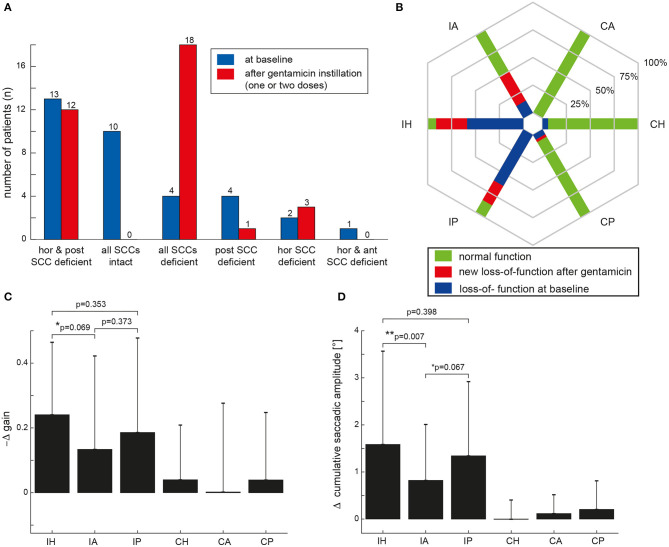
(A) Distribution of ipsilesional impairment in semicircular canal (SCC) function based on the two reviewers' ratings both at baseline (in blue) and after intratympanic gentamicin treatment (one or two treatments, individually different) (in red). In (B), the percentage of patients with normal function before and after gentamicin instillation (green areas) and with hypofunction based on the reviewers' overall ratings for the different SCCs [horizontal (H), anterior (A) and posterior (P)] are illustrated in a hexplot, differentiating between the ipsilesional (I) and the contralesional (C) side in the plot. Loss of function at baseline (indicated by the blue bars) is distinguished from new SCC hypofunction after intratympanic gentamicin application (indicated by the red bars); thus, the overall fraction of SCC impairment after gentamicin treatment is reflected by the red plus the blue fraction. In (C,D), the mean (±1 SD) changes (Δ) in aVOR gain (C) and CSA (D) after intratympanic gentamicin application compared to baseline measurements (i.e., by subtracting the aVOR gain/the CSA at baseline from the aVOR gain/CSA after gentamicin instillation) are illustrated for all six SCCs. Note that aVOR-gain reductions after gentamicin instillation will result in a negative Δ gain [as indicated along the y-axis in (C)]. Results of the statistical analysis (GLM) are shown for the ipsilesional (I) side only as there were no significant changes (p > 0.05) on the contralesional (C) side. Differences with a trend to significance were indicated by “*,” whereas significant (i.e., p < 0.05) differences were marked with a “**.”